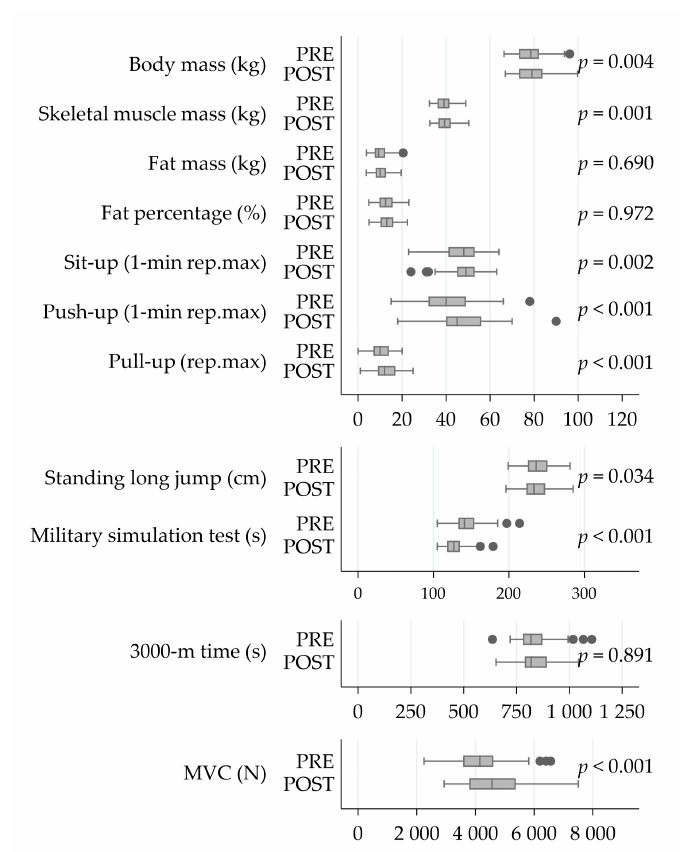
Figure 3. The changes in body composition and physical performance during the operation. Signifi- cances have been calculated using the Student’s paired-test. Abbreviations: PRE, at the beginning of a six-month crisis-management operation; POST, at the end of a six-month crisis-management operation; Rep.max, repetition maximum; 3000-m, 3000 m running test; MVC, bilateral maximal isometric force of the lower extremities.